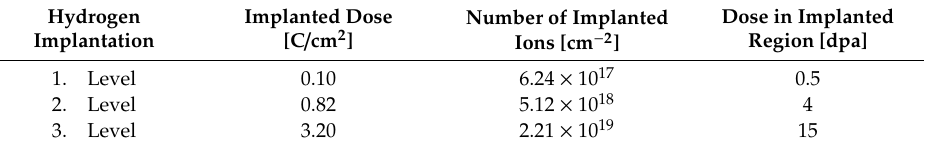
Table 2. Overview of implanted parameters in